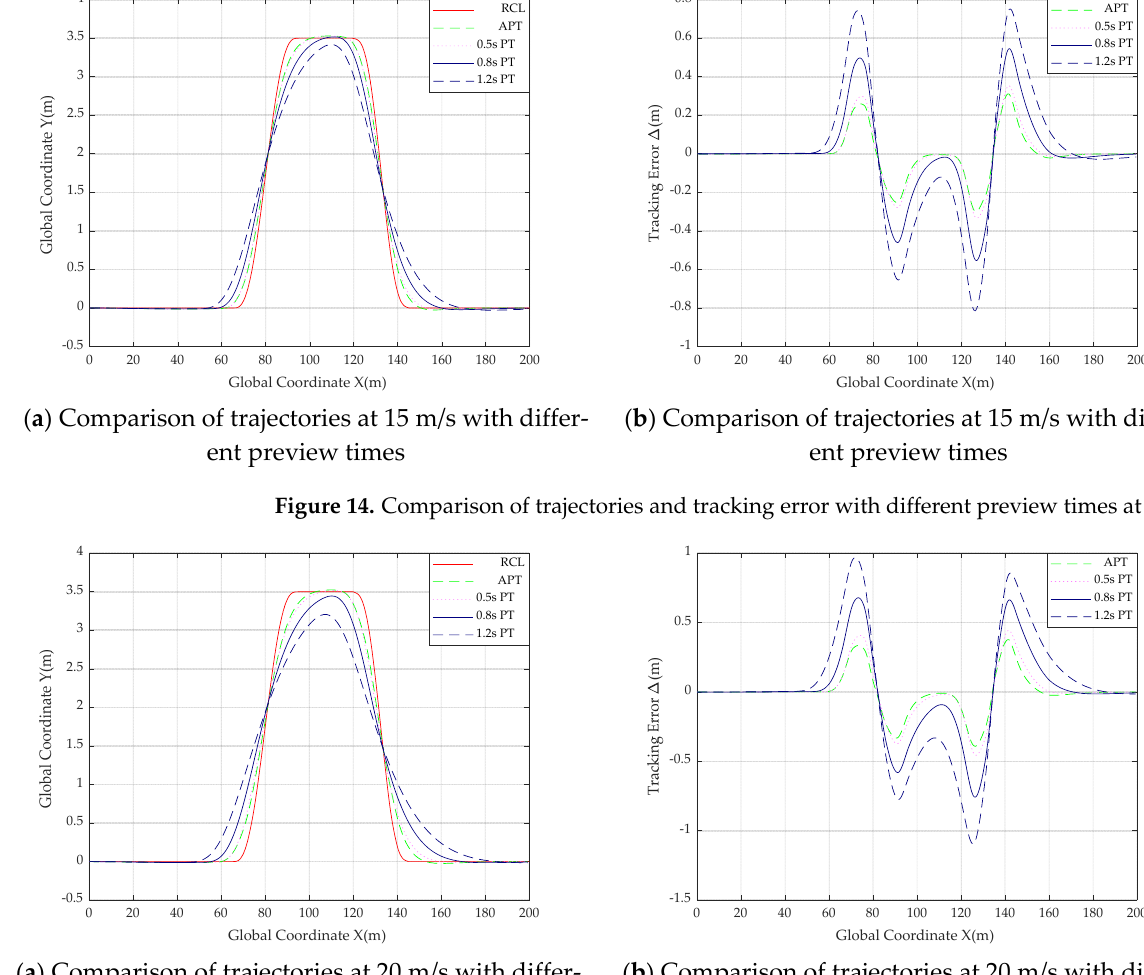
( b ) Comparison of trajectories at 20 m/s with differ ‐ Figure 15. Comparison of trajectories and tracking error with different preview times at 20 m/s.